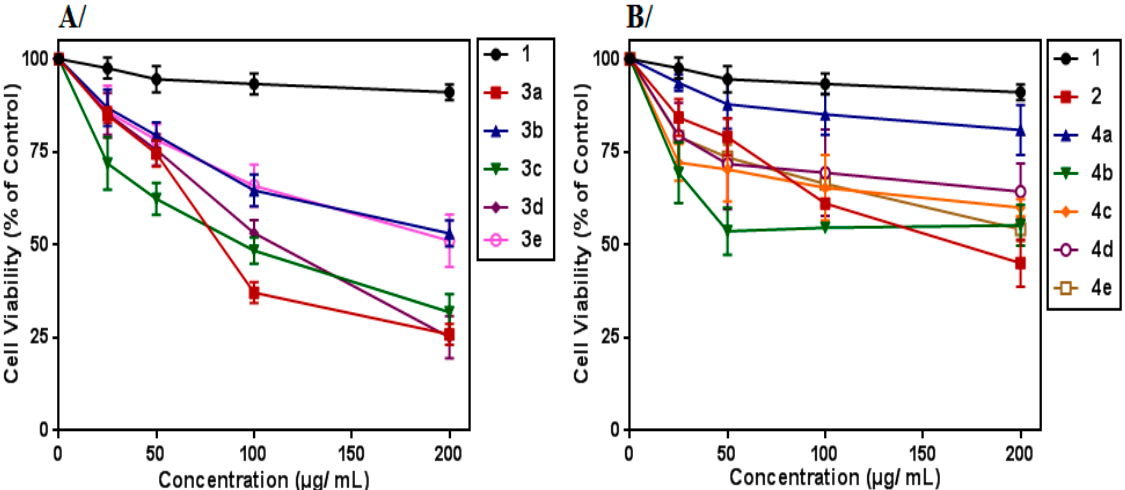
Figure 1. Tyrosol derivatives affected K562 cells’ viability: ( A ) K562 cells treated with tyrosol ( 1 ) and the synthesized isoxazoles ( 3a – e ); ( B ) cells treated with tyrosol ( 1 ), tyrosol-alkyne ( 2 ) and the synthesized triazoles ( 4a – e ). Cells were treated with increasing concentrations for 24 h, and their viability was determined by the metabolic rate using the MTT assay. Absorbance values were measured at 560 nm and normalized against untreated cells. Data represent the mean ± SEM of three independent experiments performed in triplicate. All data were statistically significant ( p < 0.05), except tyrosol (1) (at 25, 50 and 100 µg/ mL) and 4a at 25 µg/mL.